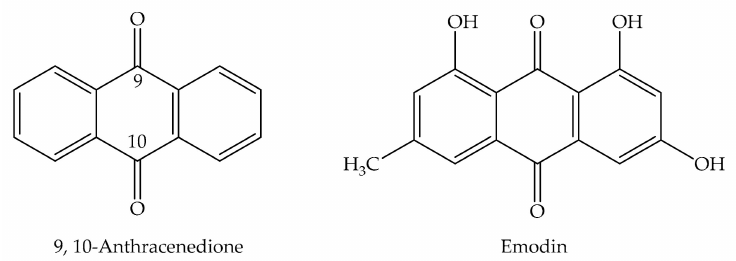
Figure 2. Chemical structures of 9,10-anthracenedione and